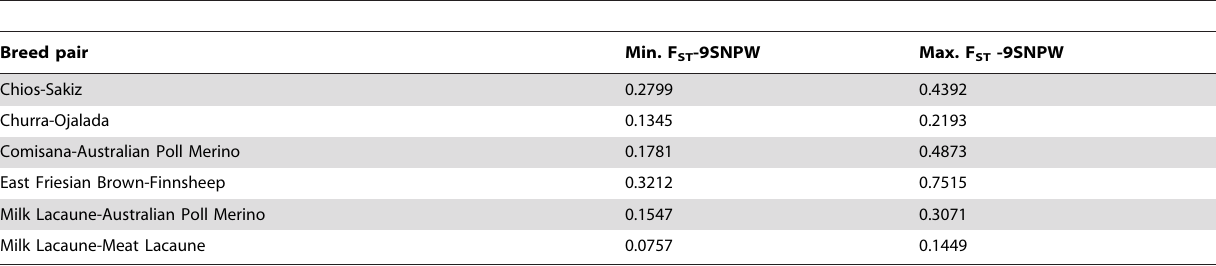
Table 2. Maximum and minimum of the 0.005 top averaged pair-wise F ST values in sliding windows of 9 SNPs (F ST -9SNPW) estimated for the pairs considered in the present work to detect selection signals in dairy sheep.